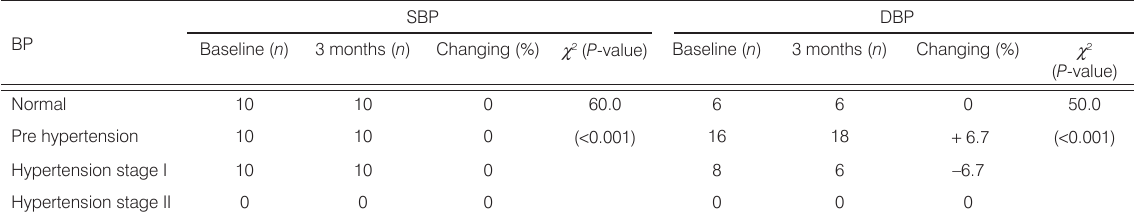
Table 2. Comparison of SBP and DBP baseline and 3 months data in control and intervention groups ( n = 90).